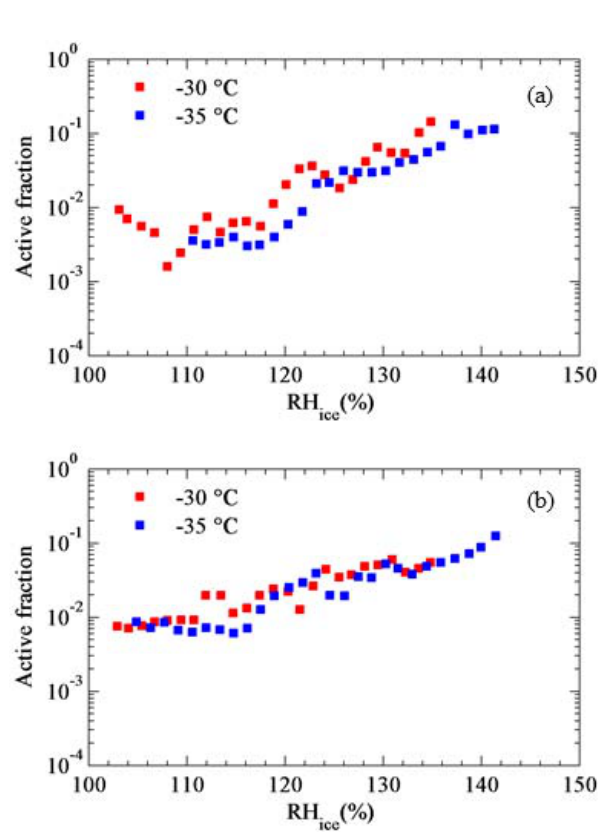
Fig. 5. Active fraction of 400nm size (a) ATD and (b) kaolinite particles as a function of RH ice (%). The particles were investigated at temperatures of − 30 and − 35 ◦